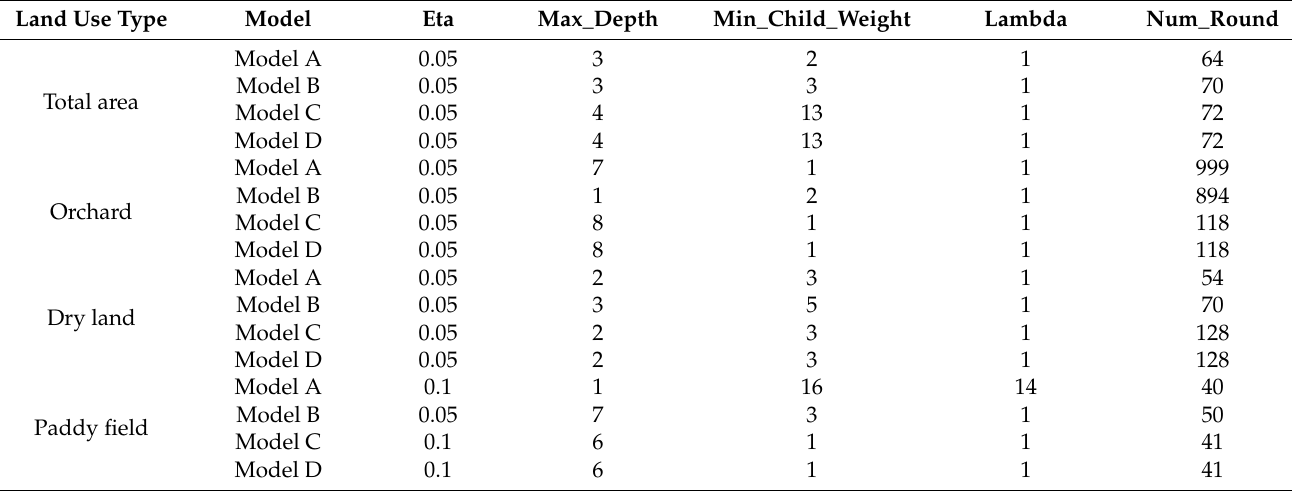
Table A3. The optimal values of parameters for models with different input combinations under total area, orchard, dry land, and paddy